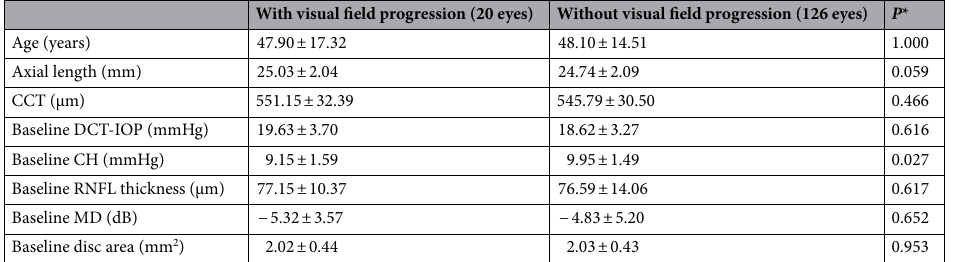
Table 4. Comparisons of baseline ocular biometry, visual field, optic nerve head (ONH), retinal nerve fiber layer (RNFL), corneal hysteresis (CH) and intraocular pressure (IOP) measurements (DCT-IOP) between eyes with and without visual field progression. CCT—central corneal thickness; DCT-IOP—diastolic intraocular pressure; MD—mean deviation; CH—corneal hysteresis. *Comparisons were performed using Linear mixed modeling.